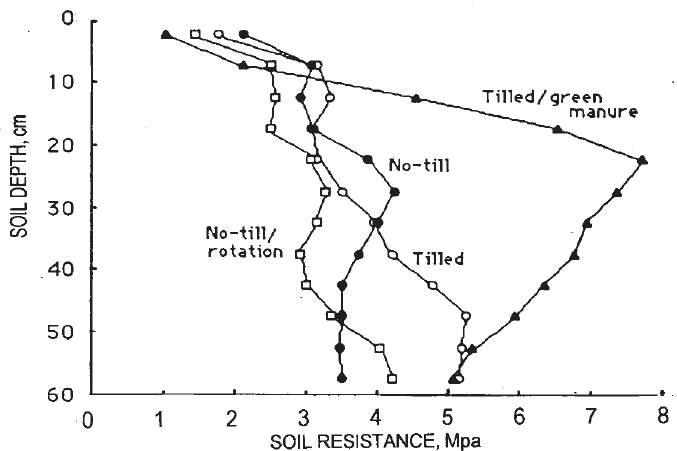
Figure 4. Effect of crop management systems and depth on soil resistance. Each value is the mean of 33 measurements.